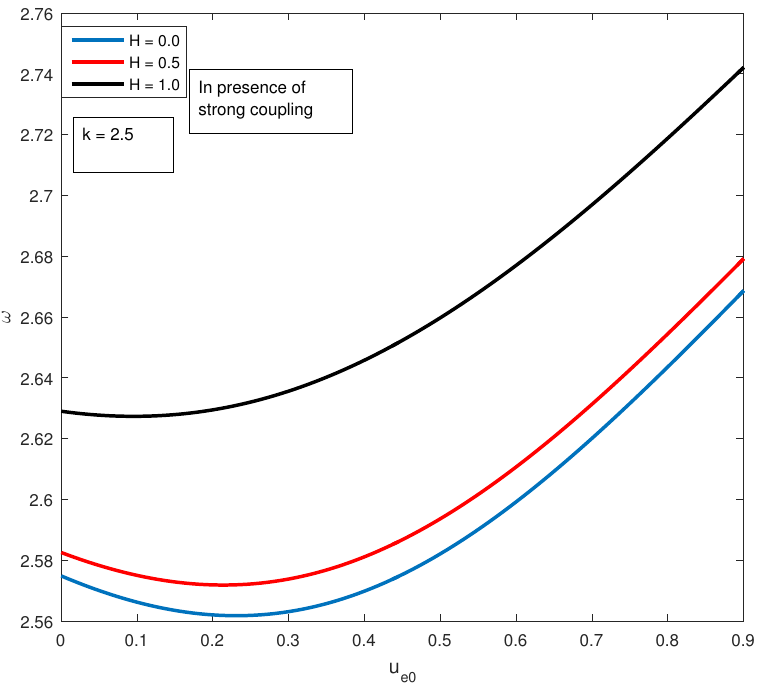
Figure 4. The variation of the wave frequency with the electron streaming velocity. In this case, we see that the wave frequency varies quite clearly with the quantum parameter ‘ H ’.